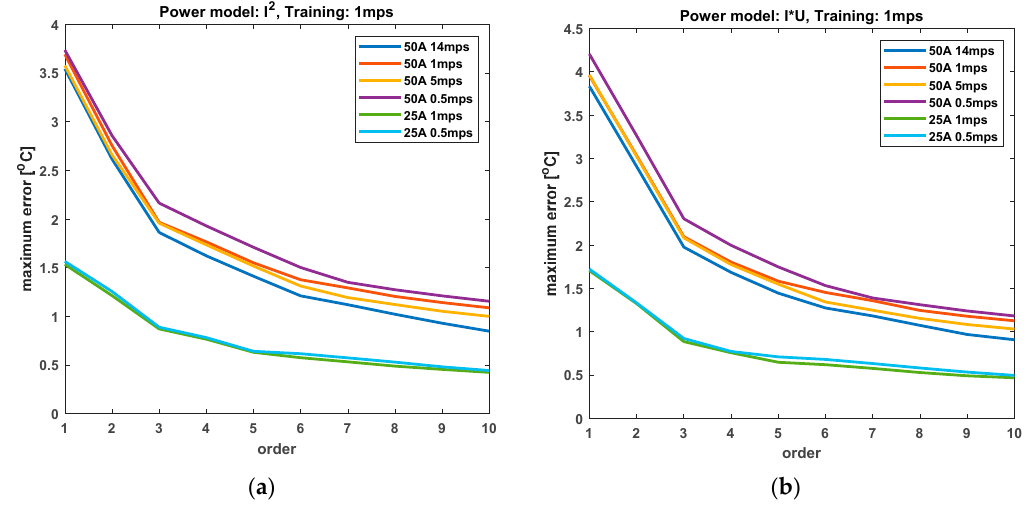
Figure 6. Maximum error vs. model order least squares ( a ) I 2 power model ( b ) IU power model. The 3rd order modelled top transistor temperature (model Equation (12)) and measured top transistor temperatures with 𝜆 = 1 are shown in Figure 7.